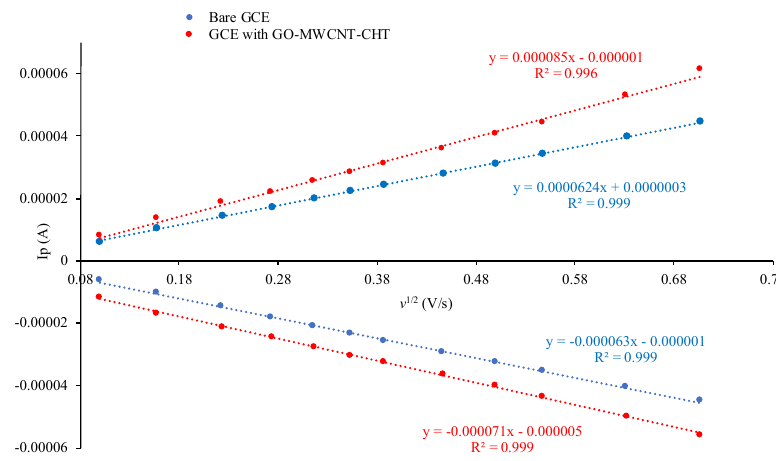
Figure 9. Linear dependence of i p on v for bare GCE and GCE/GO ‐ MWCNT ‐ CHT.